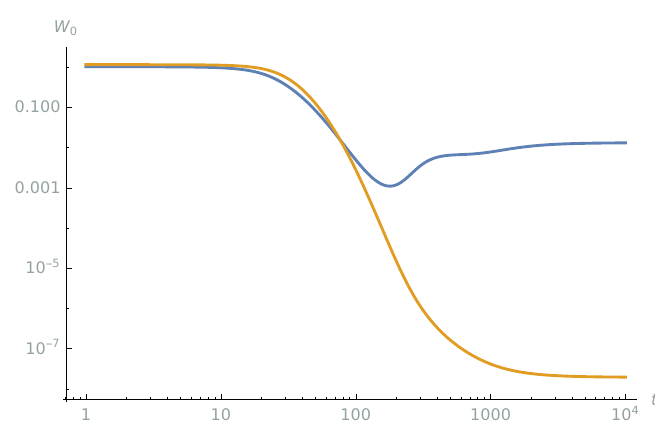
Figure 25 . The out-of-time ordered four-point function with the extrinsic curvature correction (blue) compared to the two-point function found as the exponentiated geodesic distance